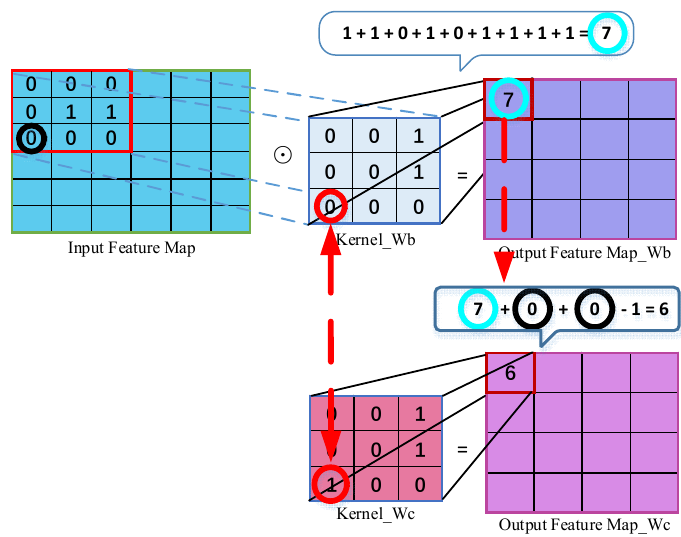
Figure 1. Kernel inclusion similarity